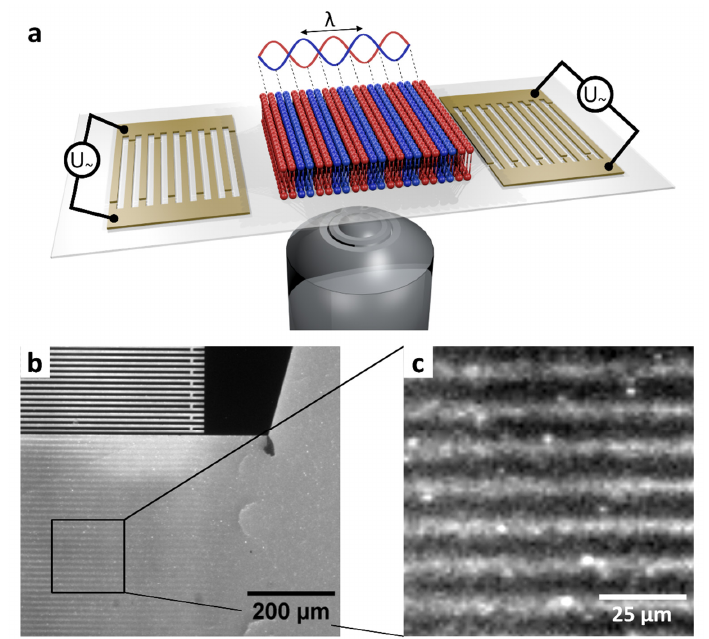
Figure 2. Formation of domains in a SLB of DOPC lipids with 0.25 mol% fluorescent dye DiOC 14 by applying a SAW standing wave field. ( a ) Sketch of the experimental setup. By applying a RF signal with the resonance frequency f 0 = 163.5 MHz at two IDT a standing wave is generated, which leads to a density modulation in a SLB. ( b ) The domains are spatially confined to the aperture of the IDT. Outside the excitation region partial extensions of the domains appear. ( c ) Enlarged view of the clearly visible stripe pattern generated by the SAW standing wave field.